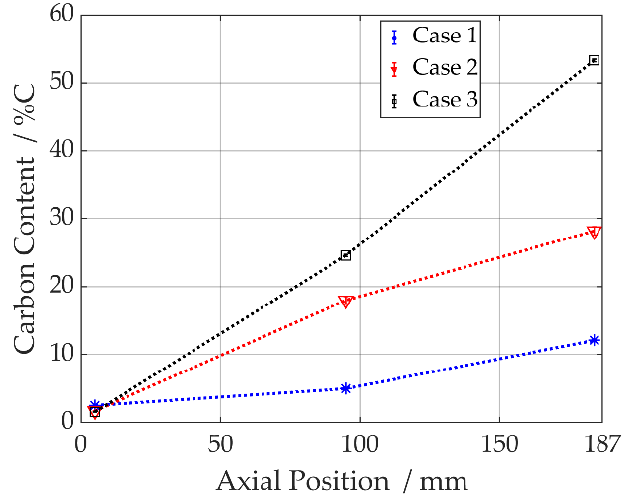
Figure 10. Sediment overall carbon content for the three cases at bottom, middle and top axial position. Blue: 20,000 rpm; Red: 40,000 rpm; Black: Increasing rotational speed. Squares: mean values; bars: Standard deviations; lines are guides to the eye.